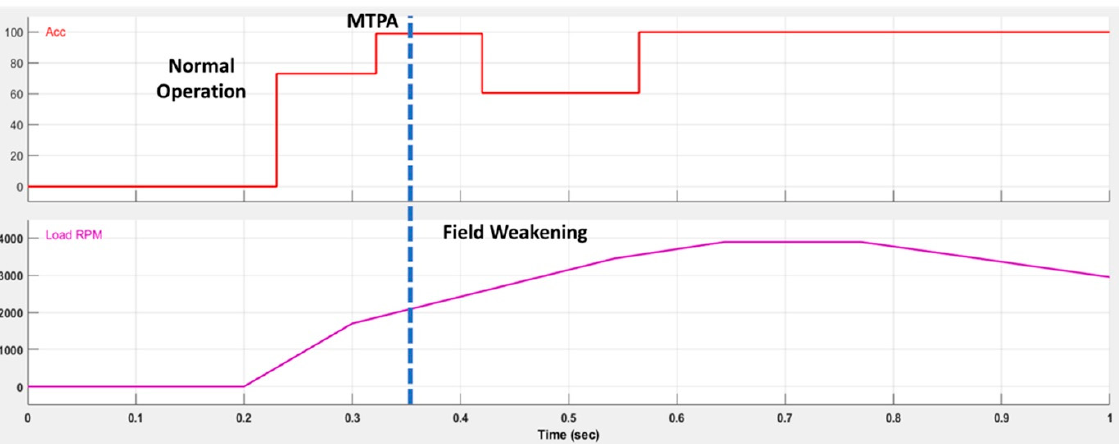
Figure 10. Controller simulation inputs.